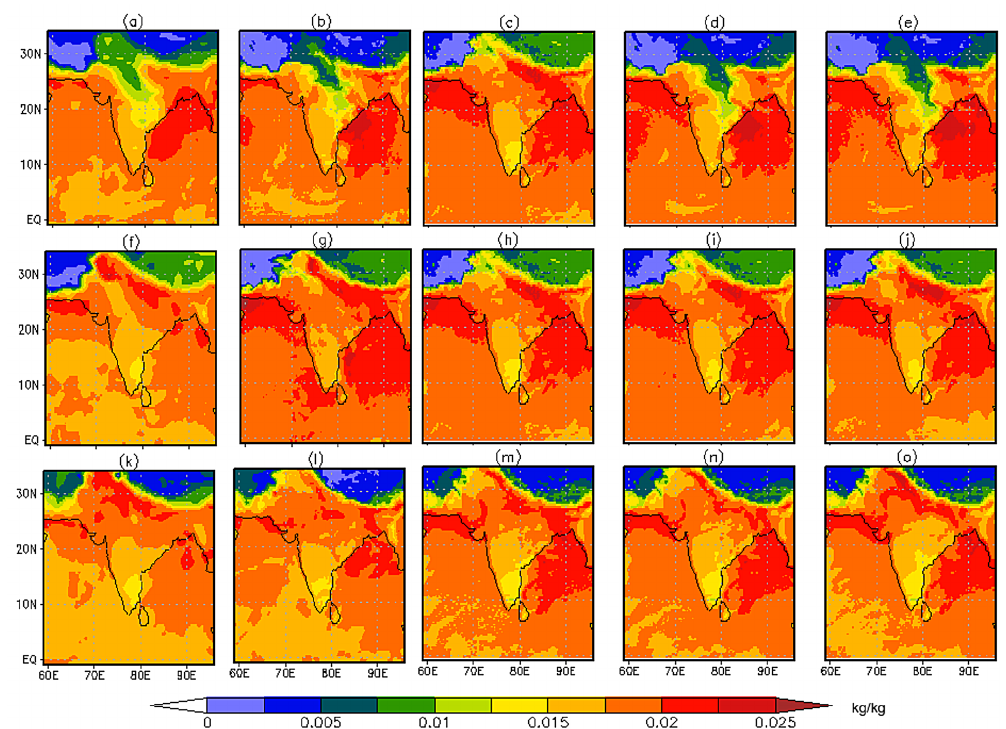
Figure 6. Water vapour mixing ratio at level 1 compared with the ECMWF reanalysis at the analysis time of the cv5/cv6 sensitivity experi- ments at level 1 for case 1 (a–e) , case 2 (f–j) and case 3 (k–o) depressions for ECMWF reanalysis (a, f, k) , high-resolution analysis (b, g, l) , CTRL run (c, h, m) , cv5 run (d, i, n) and cv6 run (e, j, o)